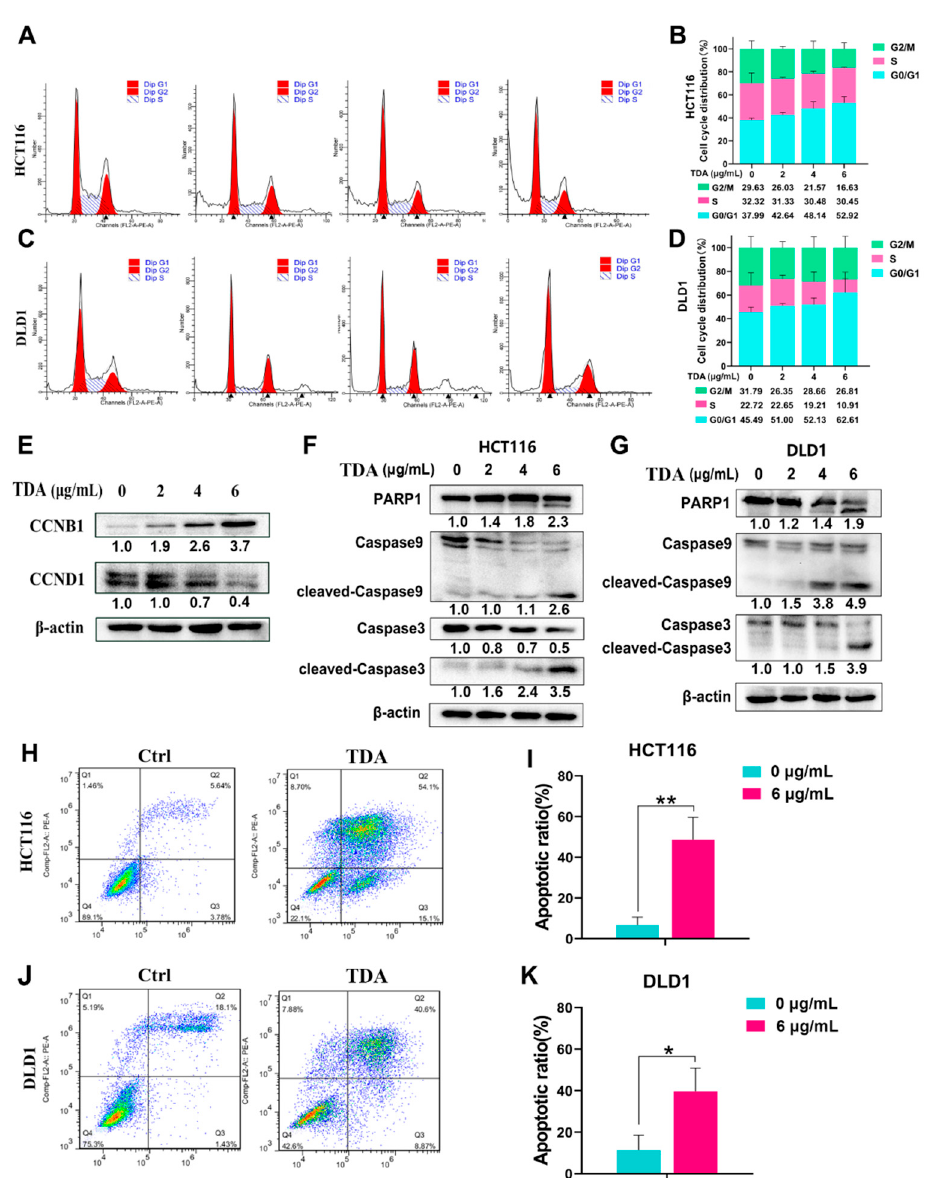
Figure 2. Flow cytometric analysis of colon cancer cells with TDA treatment. ( A – D ) Flow cytometric analysis of cell cycle in HCT116 and DLD1 cells upon TDA treatment as indicated concentration for 24 h was performed. ( E ) The expression of cyclin B1 and cyclin D1 in HCT116 cells with TDA treatment as indicated concentration for 24 h was detected by immunoblotting analysis. Beta-actin was used as internal control. ( F , G ) The protein expression levels of PARP1, cleaved PARP1, Caspase 9, cleaved Caspase 9, Caspase 3 and cleaved Caspase 3 in colon cancer cells treated with the indicated concentrations of TDA for 24 h were detected by Western blot. ( H – K ) Flow cytometric analysis of apoptosis in HCT116 and DLD1 cells upon TDA (6 µ g/mL) treatment was performed for 24 h. ( H , J ). The percentage of apoptotic HCT116 and DLD1 cells treated with TDA is shown ( I , K ). Western blot results were quantified using Image J software, and the results were numerically marked below each band. Data are presented as the mean ± SD from at least three separate experiments. * p < 0.05; ** p <